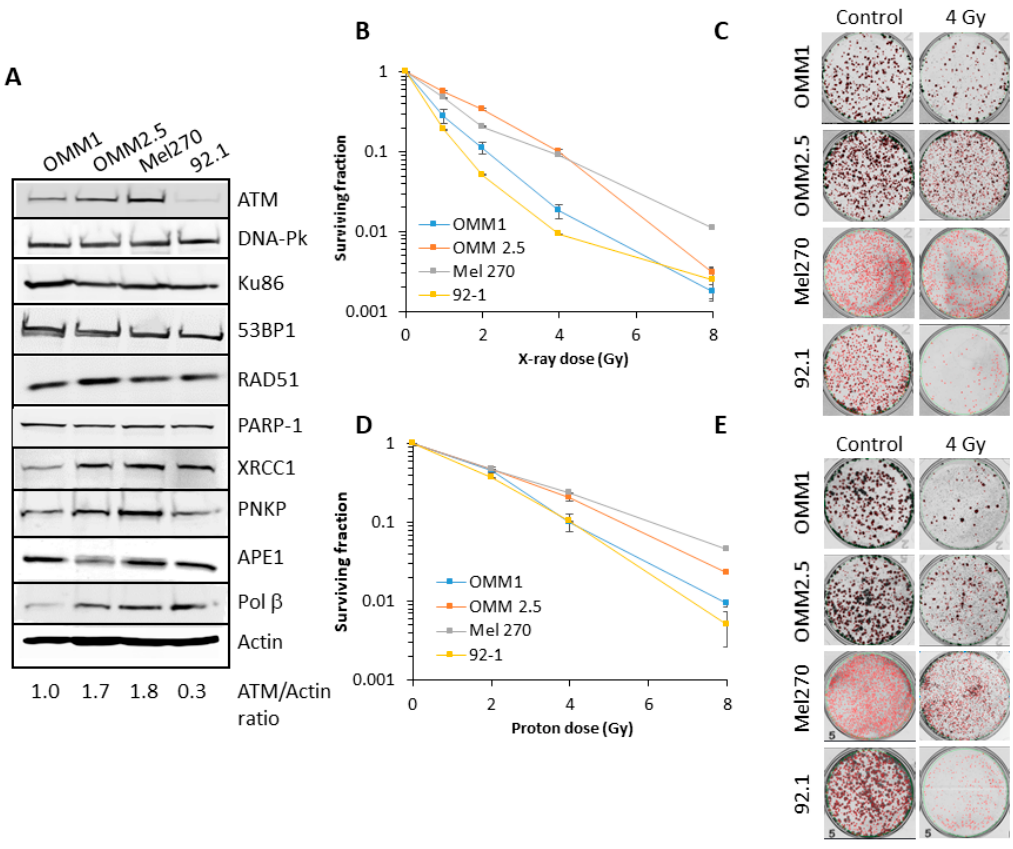
Figure 1. Comparative radiosensitivity of UM cells in response to photons and protons. ( A ) Whole cell extracts from UM cells were prepared and analyzed by immunoblotting with the indicated antibodies. Clonogenic survival of UM cells following treatment with increasing doses of ( B – C ) X-rays or ( D )–( E ) protons was analyzed from three independent experiments. ( B ) and ( D ) Shown is the surviving fraction ± S.E. ( C ) and ( E ) Representative images of colonies in non-irradiated and irradiated plates (the latter were seeded with double the number of cells, accordingly).